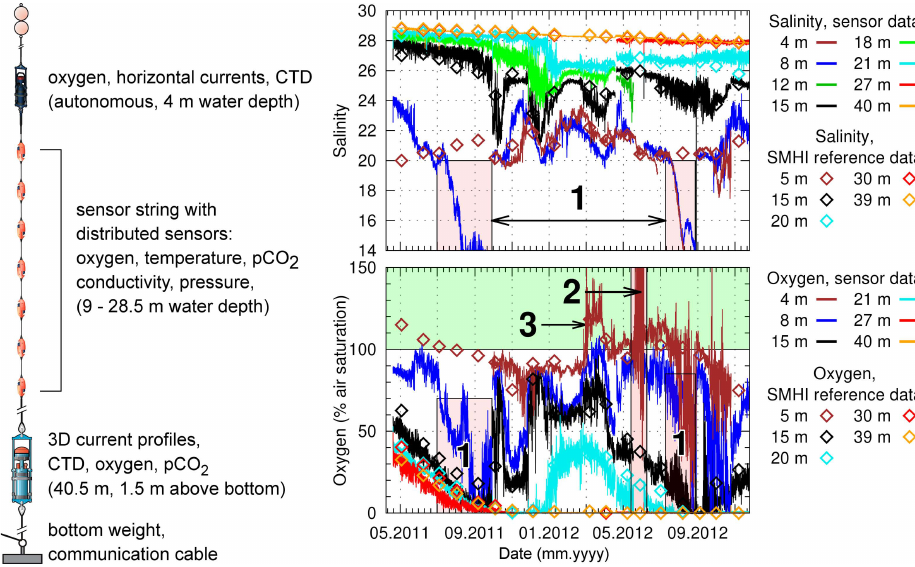
Fig. 27. Left-hand panel: schematic diagram of the cabled observatory at Koljoe Fjord. More than 30 sensors for measuring temperature, salinity, water level, turbidity, oxygen, and currents, including 3-D current profiles and backscatter from particles in the water column, are connected to data loggers (Seaguard and RDCP, AADI, Bergen, Norway). An offline self-logging shallow system (not shown) used for monitoring conductivity, temperature, and oxygen at 4m depth was updated with sensors for pH, CO 2 , DOM, Chl a fluorescence, and horizontal current in October 2012. Right-hand panel: salinity and oxygen time series (curves; measurement interval = 0 . 5h), and SMHI monthly reference data (diamonds). The pink boxes mark periods of (1) strong biofouling by sessile fauna (mostly tunicates and mussels) that occurred during the summer months on sensors deployed at depths of 4 and 8m in warm oxygenated surface water, and (2) biofouling by algae in late spring. Summer biofouling by fauna (1) resulted in severe underestimates of salinity and oxygen concentration as compared to the reference data, while spring biofouling by algae (2) led to strong peaks in the oxygen reading around midday due to photosynthetic activity on the surface of the oxygen optodes. The effects of biofouling were observed until the observatory had been recovered and cleaned. The increase in surface water oxygenation in spring 2012 (3) was due to a spring bloom of diatoms in the surface waters (the greenish area indicates oxygen concentrations above 100% air saturation). Gaps in the data are due to instrument maintenance. More detailed information is available at